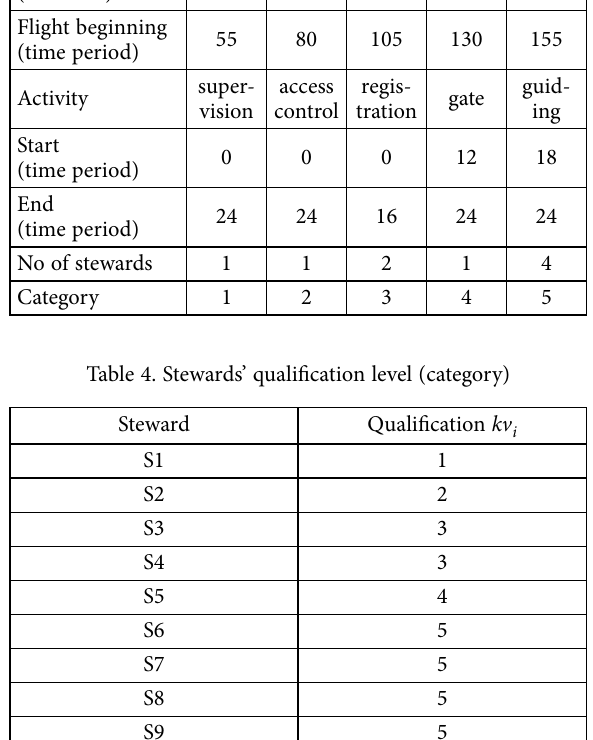
Figure 6. Example of overlapped activities for 2